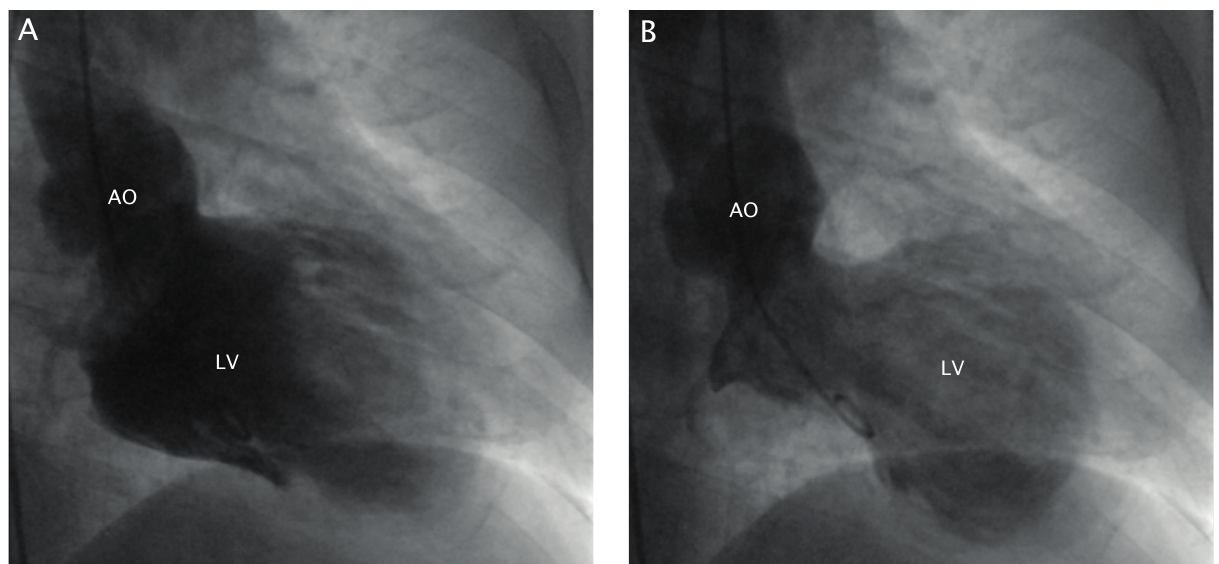
Fig. 3. Left ventriculography (A – diastolic, B – systolic): large dyskinesia of left ventricle apex and akinesia of anterior wall with severely impaired left ventricle systolic function with the ejection fraction of 25%. Right anterior oblique 30° projection. AO, aorta; LV, left ventricle.